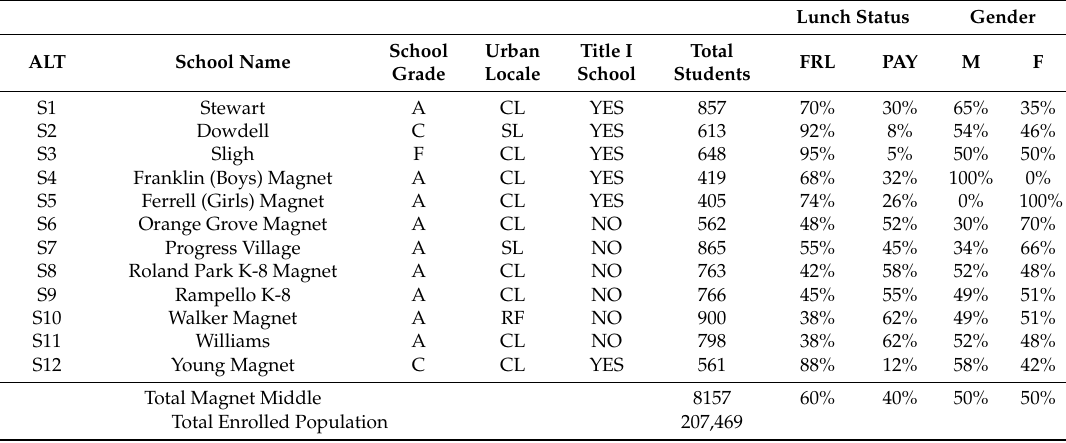
Table 1. School enrollment data for SDHC magnet middle school programs for the 2015/2016 academic